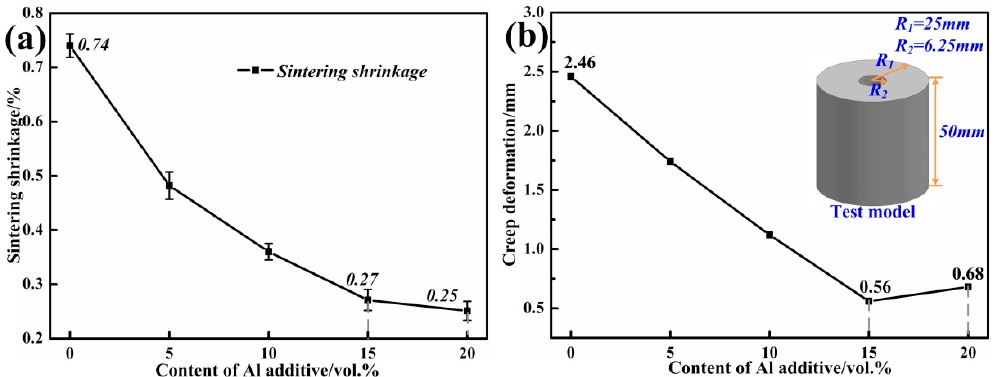
Figure 8. ( a ) Sintering shrinkage of SiO 2 ceramic molds with 0, 5, 10, 15, and 20 vol % Al additive; ( b ) Creep deformation of SiO 2 ceramic molds with 0, 5, 10, 15, and 20 vol % Al additive.